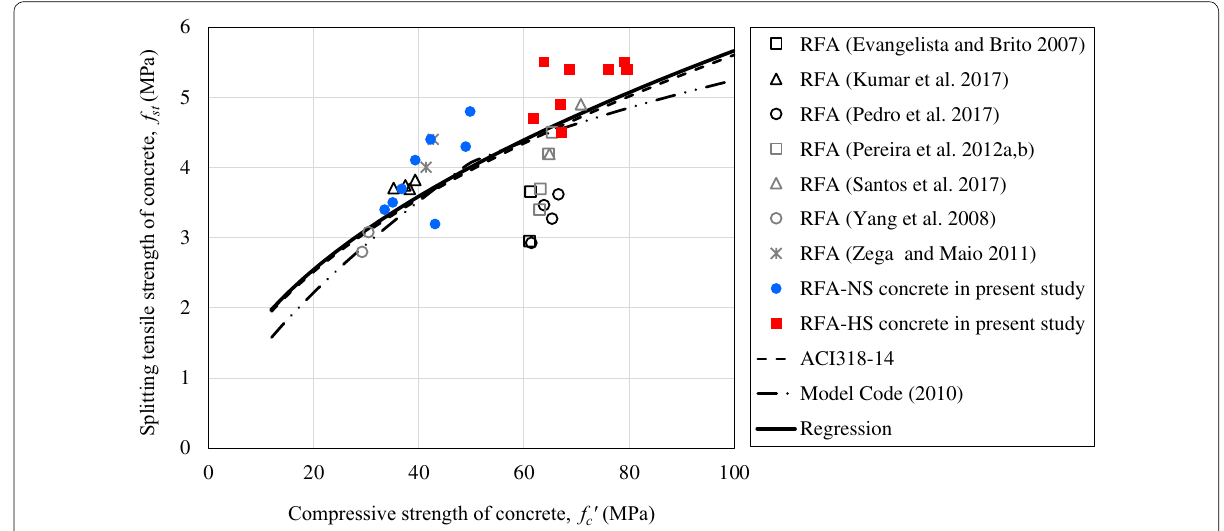
Fig. 9 Relationship between the compressive and tensile strength of RFA concrete.